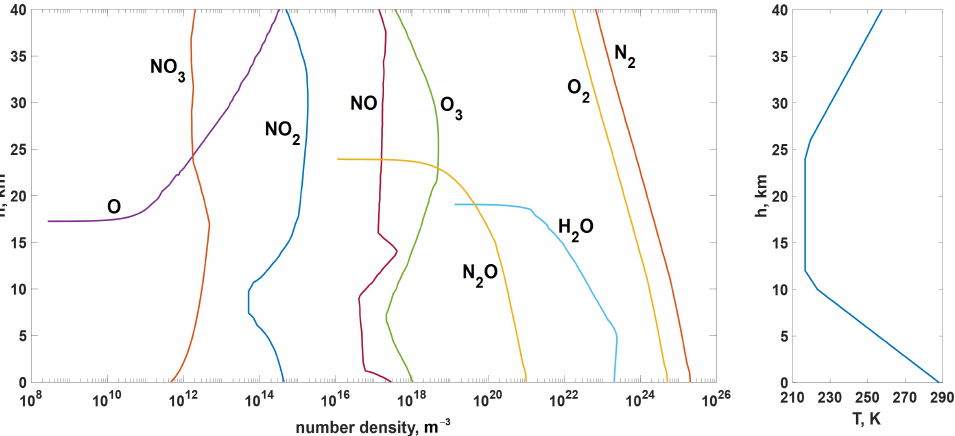
Figure 1. Altitude distributions of atmospheric air composition and